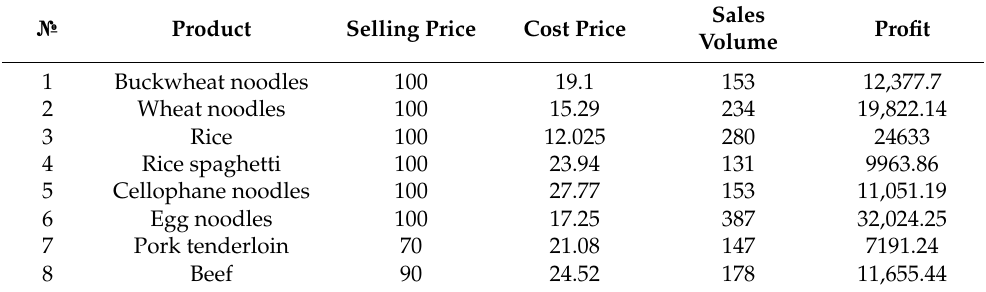
Table 2. Input data.